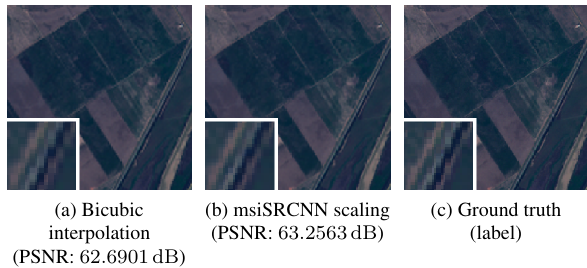
Figure 9: msiSRCNN scaling results for RGB